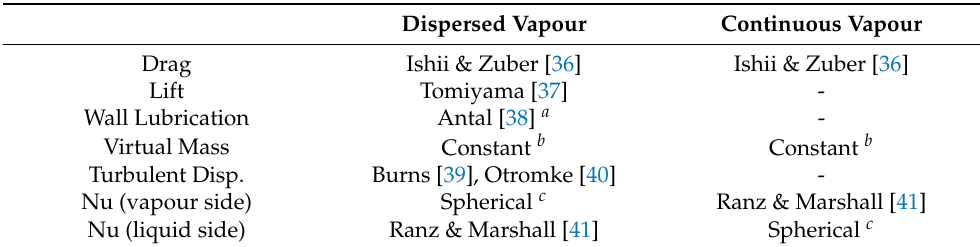
Table 1. Momentum and heat transfer interfacial models. a Wall lubrication coefficients C w 0 = −